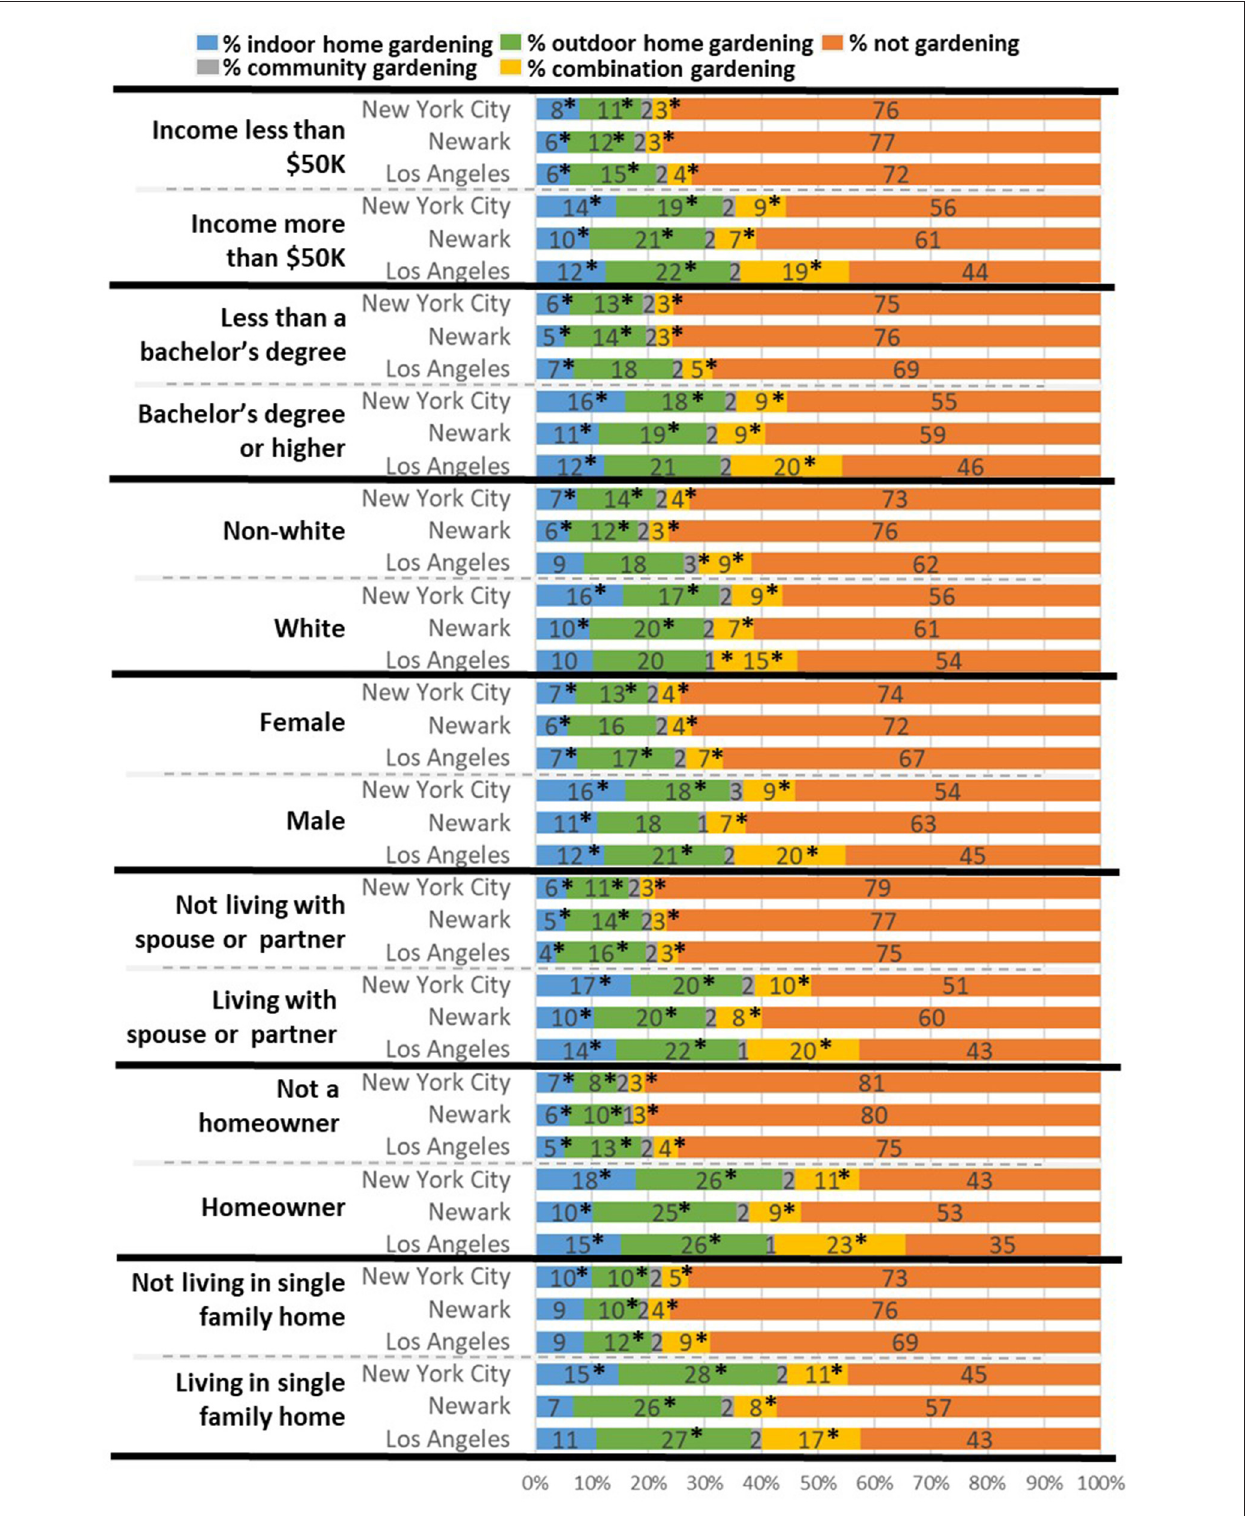
FIGURE 1 | Demographic group comparisons of those engaged in urban agriculture by gardening category. Comparisons are across pairs for each gardening category by income (high/low), education, race (White vs. non-White), gender, living with spouse/partner, homeownership, and housing type. *statistical significance across pairs at 95%